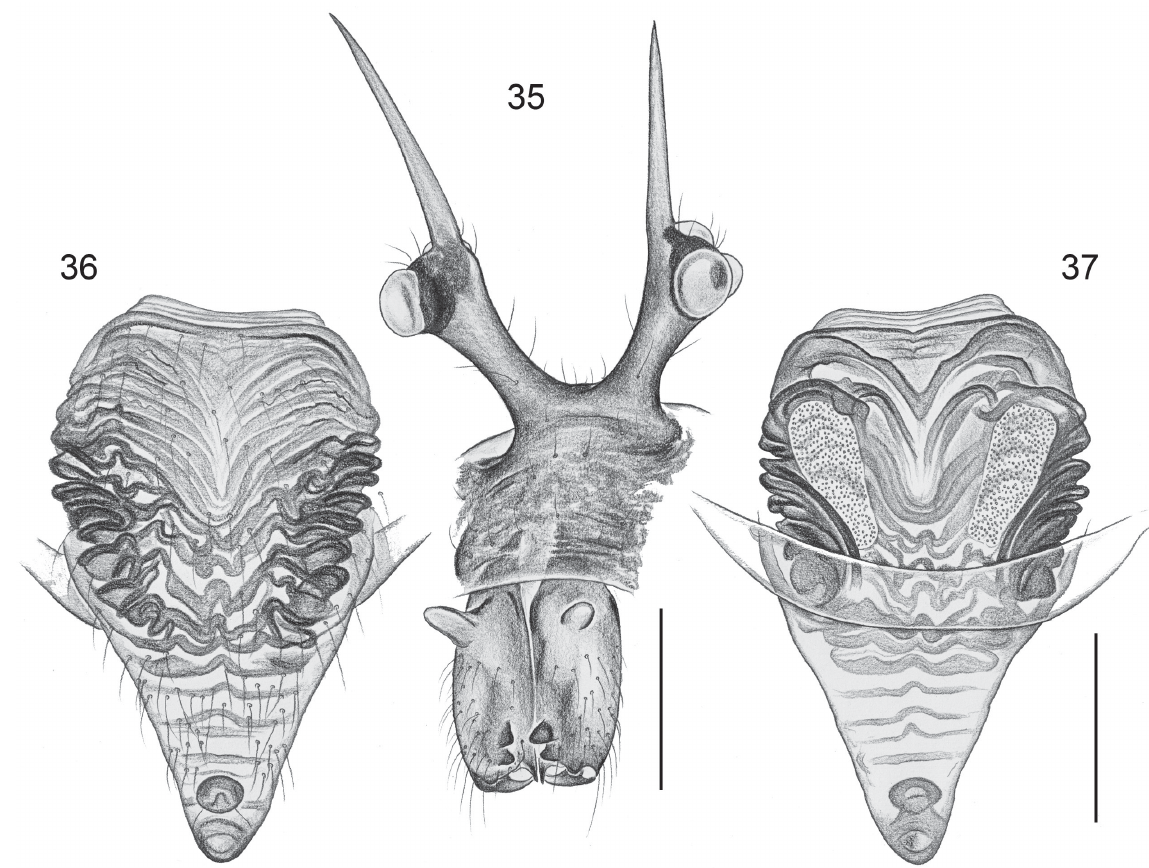
Figs 35–37. Panjange kapit Huber, sp. nov. (ZFMK Ar 14583–84). 35 . Male ocular area, clypeus, and chelicerae, oblique frontal view. 36–37 . Cleared female genitalia, ventral and dorsal views. Scale lines: 0.5